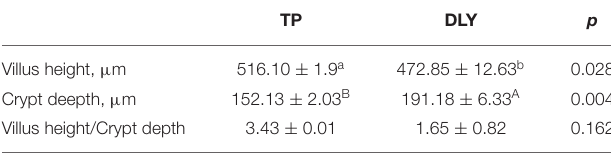
TABLE 2 | Comparison of jejunal intestinal morphology of growing DLY and TP